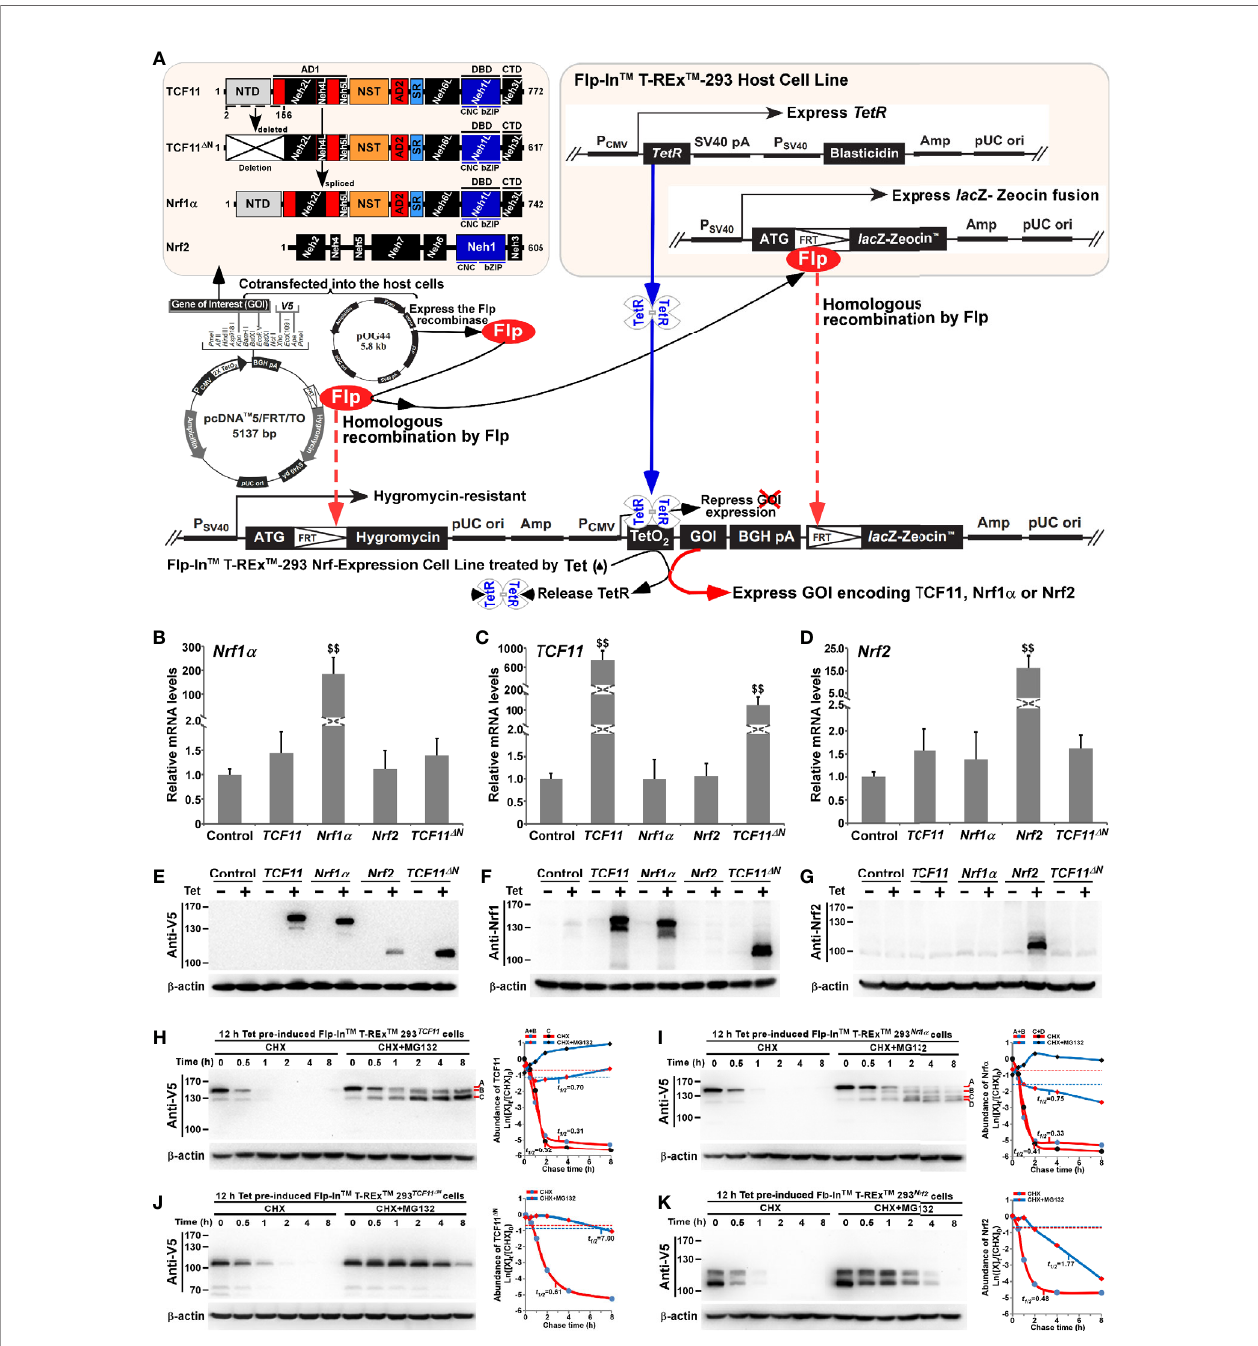
FIGURE 1 | Establishment of four distinct model cell lines to stabilize expression of TCF11 , TCF11 D N , Nrf1 a and Nrf2 . (A) A schematic diagram of the Flp-In ™ T- REx ™ -293 system. The system allows the Flp recombinase-mediated homologous recombination of each indicated pcDNA5/FRT/TO-V5 expression constructs (for TCF11, TCF11 D N , Nrf1 a or Nrf2) with the Flp-In ™ T-REx ™ -293 host cells through the FRT sites. (B – D) After incubation of TCF11 , Nrf1 a , Nrf2 or TCF11 D N , as well as control cell lines with 1 m g/ml Tet for 12 h, total RNAs were isolated and then reversely transcribed into the fi rst strand of cDNA. Subsequently, quantitative real- time PCR was employed to identify the mRNA expression levels of Nrf1 a (B) , TCF11 (C) , TCF11 D N (C) and Nrf2 (D) in each of indicated cell lines. The data are shown as mean ± SEM (n = 3 × 3, $$, p < 0.01, when compared to the Control ). (E – G) Total lysates of each cell line that had been treated with 1 m g/ml Tet (+) or not ( − ) were subjected to protein separation by SDS-PAGE gels, and then visualized by immunoblotting with distinct primary antibodies against V5, Nrf1 or Nrf2 to identify the protein levels of TCF11, Nrf1 a , Nrf2 and TCF11 D N . (H – K) Total lysates of experimental cells, which had been induced with 1 m g/ml Tet for 12 h before being treated with CHX (50 m g/mL) alone or in combination with MG132 (10 m mol/L) for distinct times as indicated, were resolved by SDS-PAGE and then analyzed by Wester blotting with V5 antibody to identify the stability of TCF11 (H) , Nrf1 a (I) , TCF11 D N (J) and Nrf2 (K)